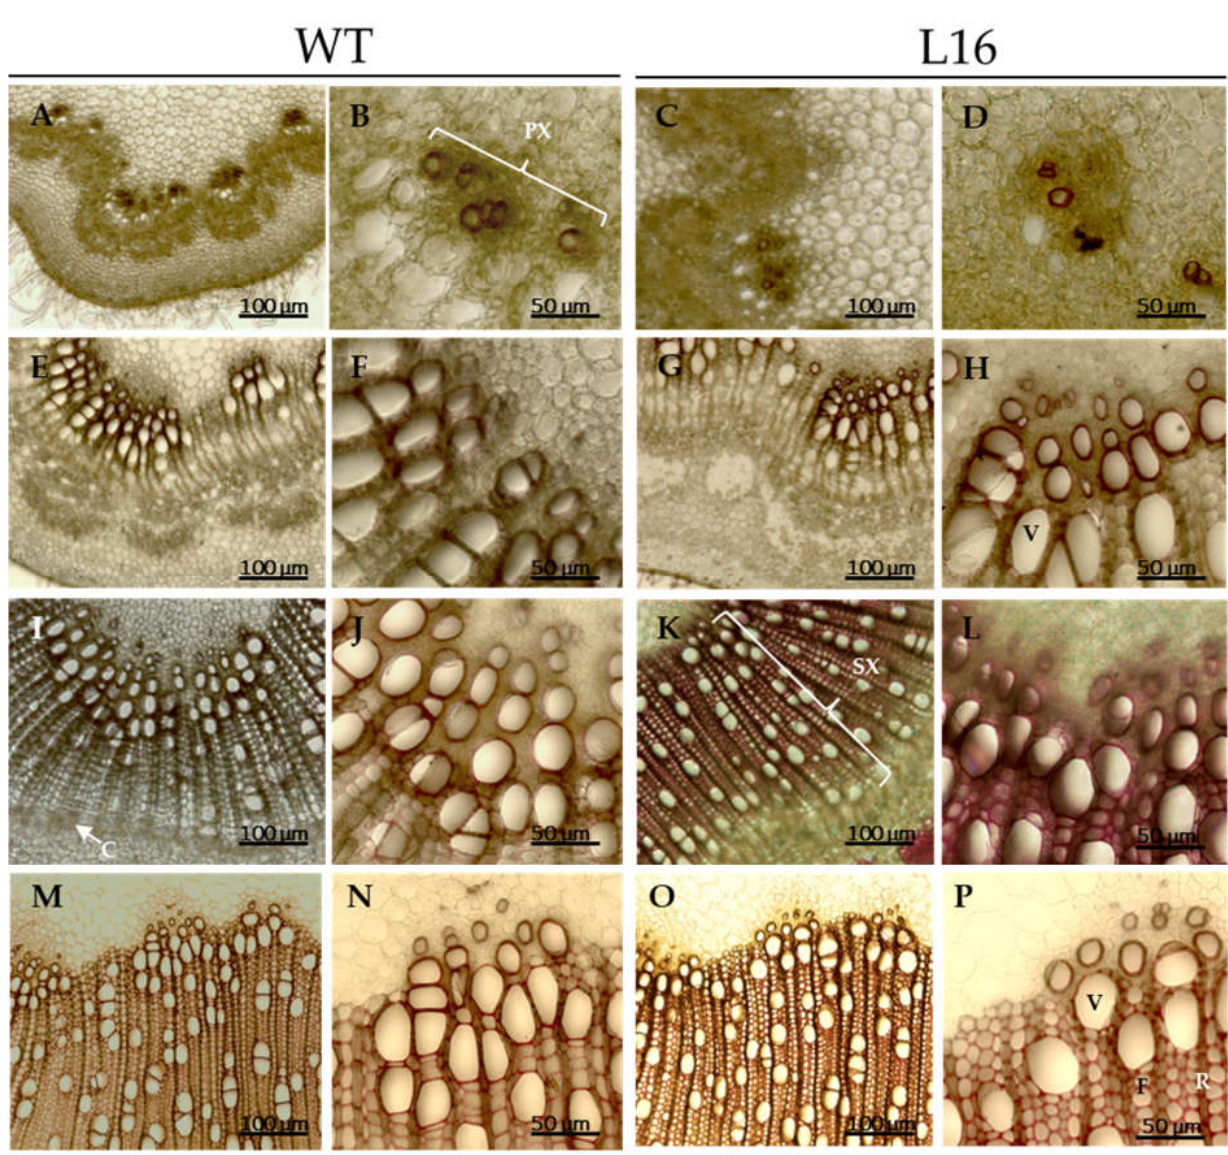
Figure 4. Wiesner staining of cross sections of stems of three-month-old WT and L16 ugt72b37 mutants: ( A – D ) 1 cm below the apex; ( E – H ), 10 cm below the apex; ( I – L ), 20 cm below the apex; and ( M – P ), 30 cm below the apex. ( B , D , F , H , J , L , N , P ) were close-ups of ( A , C , E , G , I , K , M , O ) respectively. Lignin is evidenced by pink staining. PX, primary xylem; V, vessel; C, cambium; SX, secondary xylem; F, fiber; R, ray.